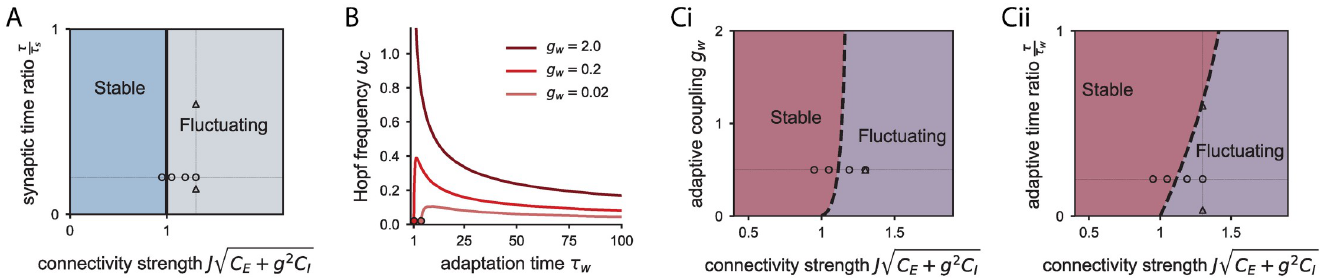
Fig 4. Phase diagram and frequency of the bifurcation for the heterogeneous activity. A: Phase diagram for the network with synaptic transmission. The only relevant parameter to assess the dynamical regime is the connectivity strength. The circles indicate the parameters used in Figs 3 and 6. Triangles correspond to the parameter combinations used in Fig 5. B: Frequency at which the eigenspectrum loses stability for the network with adaptive neurons as a function of the ratio between membrane and adaptation time constant, τ / τ , for three different adaptive couplings. The dots indicate the fastest adaptive time constant for which the system m w undergoes a Hopf bifurcation (Eq 84). C: Phase diagrams for the two adaptation parameters, (i) the coupling g w and (ii) the adaptive time constant τ w vs the coupling standard